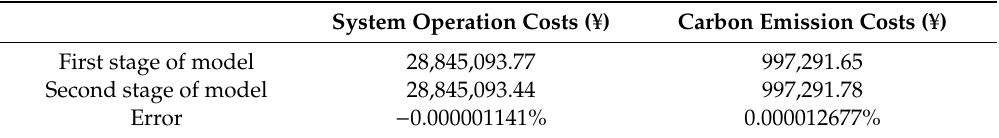
Table 4. Comparison of the system operation costs and carbon emission costs obtained from the two stages of the proposed model. stages of the proposed model.